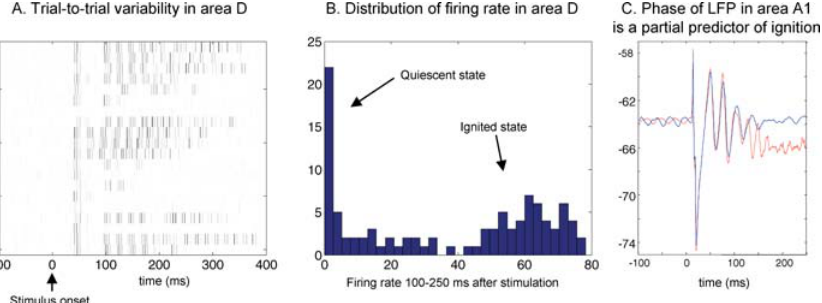
Figure 6. All-or-None Stochastic Fluctuations in the Processing of a Fixed Stimulus (A) Variability in sample spike trains evoked in area A1 by the same 15-ms stimulus, whose duration was close to ignition threshold (with I neuromodul = (cid:1) 0.9 l A/cm 2 ). Each of the twenty lines represents one trial. Note that the first peak is present on a majority of trials, while most of the variability affects the second peak. (B) Distribution of the mean firing rate in area A1 during the second peak (75–225 ms poststimulus), showing a bimodal distribution. (C) Mean local field potential in area A1, computed separately for trials that lead to ignition (firing peak . 40 spikes/s in the above time window) and for trials that did not (firing peak , 15 spikes/s). Note (1) the essentially identical stimulus-induced waves up to the sharp divergence about 110 ms poststimulus; and (2) the presence of a small but significant difference prior to the stimulus, which indicates that ignition is more likely to occur when stimulus presentation coincides with the depolarized phase of spontaneous ongoing oscillations. DOI: